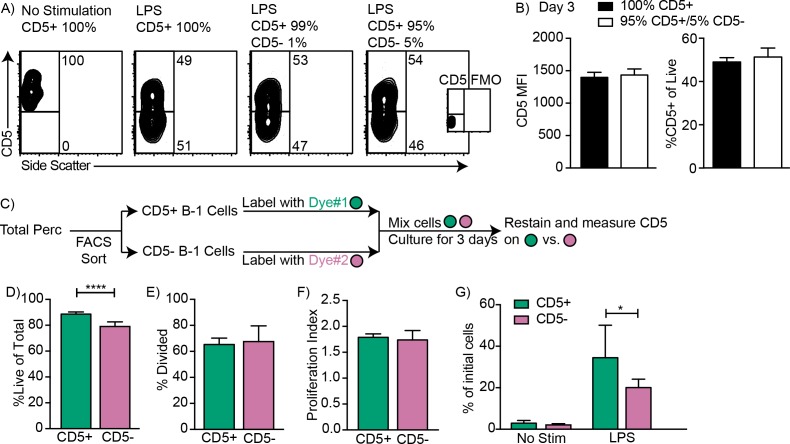
CD5- B-1 cells do not survive better or proliferate more compared to CD5+ B-1 cells.CD5+ and CD5- B-1 cells isolated by FACS from the body cavities of wild type C57BL/6 mice were cultured separately or mixed as indicated for 72 hr in the presence or absence of LPS. (A) Sample FACS plots from cultures with or without LPS of purified CD5+ B-1 cells mixed or not with indicated percentages of CD5- B-1 cells. (B) Mean CD5 MFI ± SD (left) and mean percentage ± SD of CD5+ cells (right) of cultures in A (n = 3). (C) CD5+ (green) and CD5- (purple) B-1 cells were each labeled with either CFSE or Efluor670. Dyes used to label each population were switched for repeated experiments. (D) Mean percentage ± SD of live cells, or (E) of divided cells, (F) mean number of divisions ± SD among cells that had divided, and (G) mean percentage ± SD of cell numbers on day three compared to input numbers for CD5+ and CD5- cells cultured with LPS (n = 8). Results are representative of 2 (A–B) or 4 (D–G) independent experiments. Values in (B) and (D–G) were compared using an unpaired Student’s t test (*=p < 0.05, ****=p < 0.00005).